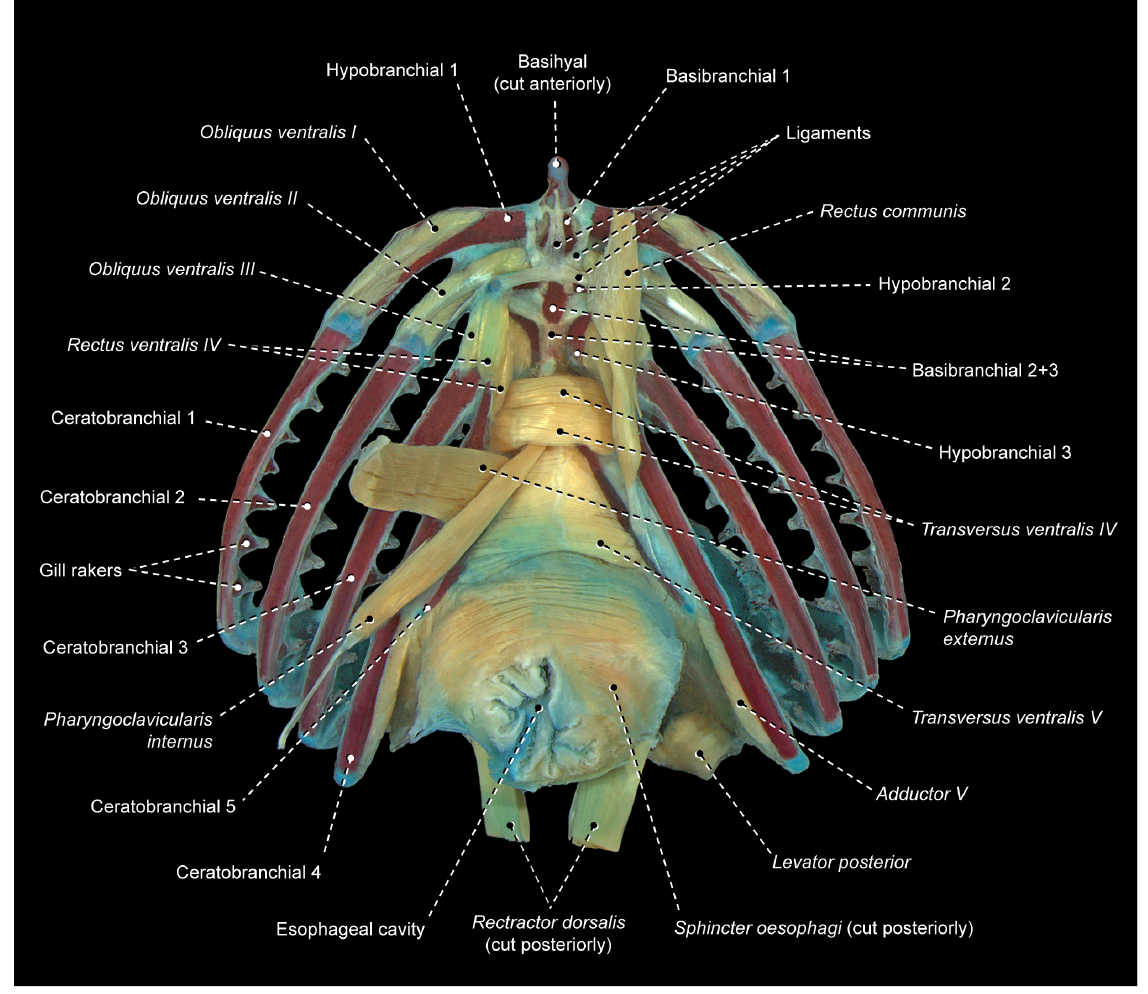
Figure 3. Branchial musculoskeletal system of Scorpaenaplumieri (Scorpaeniformes: Scorpaenidae). MZUSP 67283. Ventral view; left pharyngoclaviculares externus and internus , and right rectus communis removed.